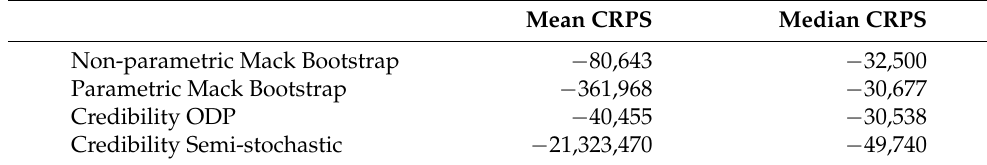
Table A2. Mean and median CRPS values if the underlying model is